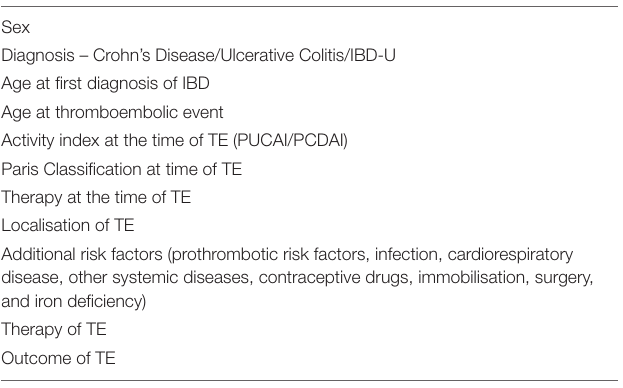
TABLE 1 | Items on the questionnaire for treating paediatric gastroenterologists on TE events. Sex Diagnosis – Crohn’s Disease/Ulcerative Colitis/IBD-U